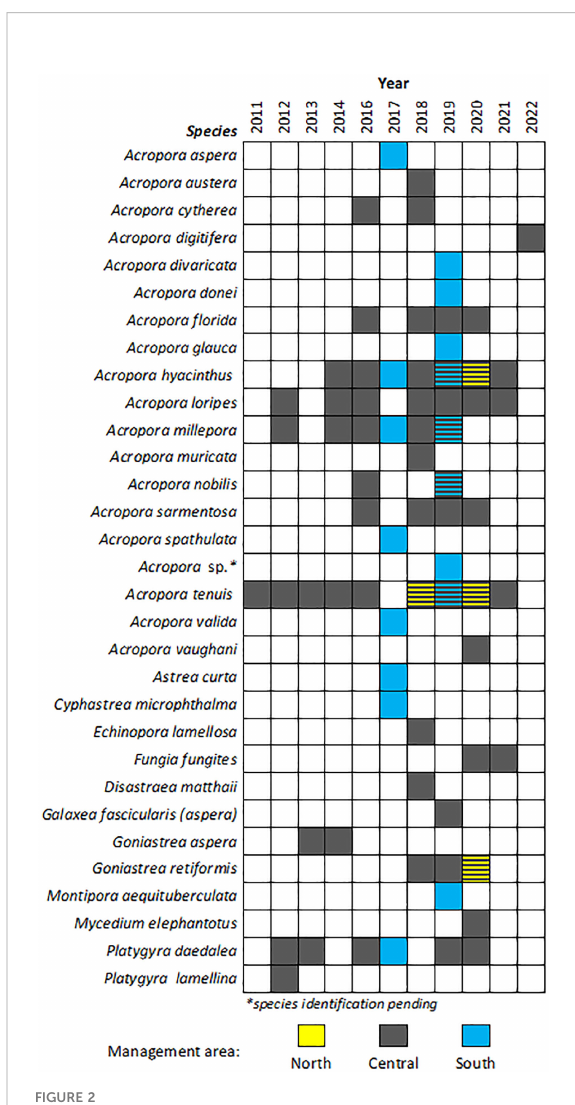
FIGURE 2 Species sampling events by year and local management area. Striped boxes indicate sampling from two MAs in a single